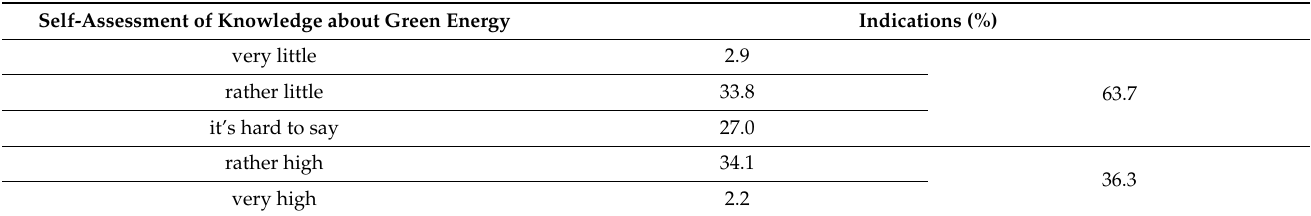
Table 2. Self-assessment of the respondents’ knowledge about green energy (%).